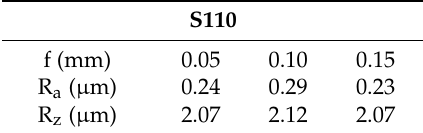
Figure 7. Scanning electron micrographs of S110 specimen with a feed rate of ( a ) 0.05 mm; ( b ) 0.10 mm; ( c ) 0.15 mm.